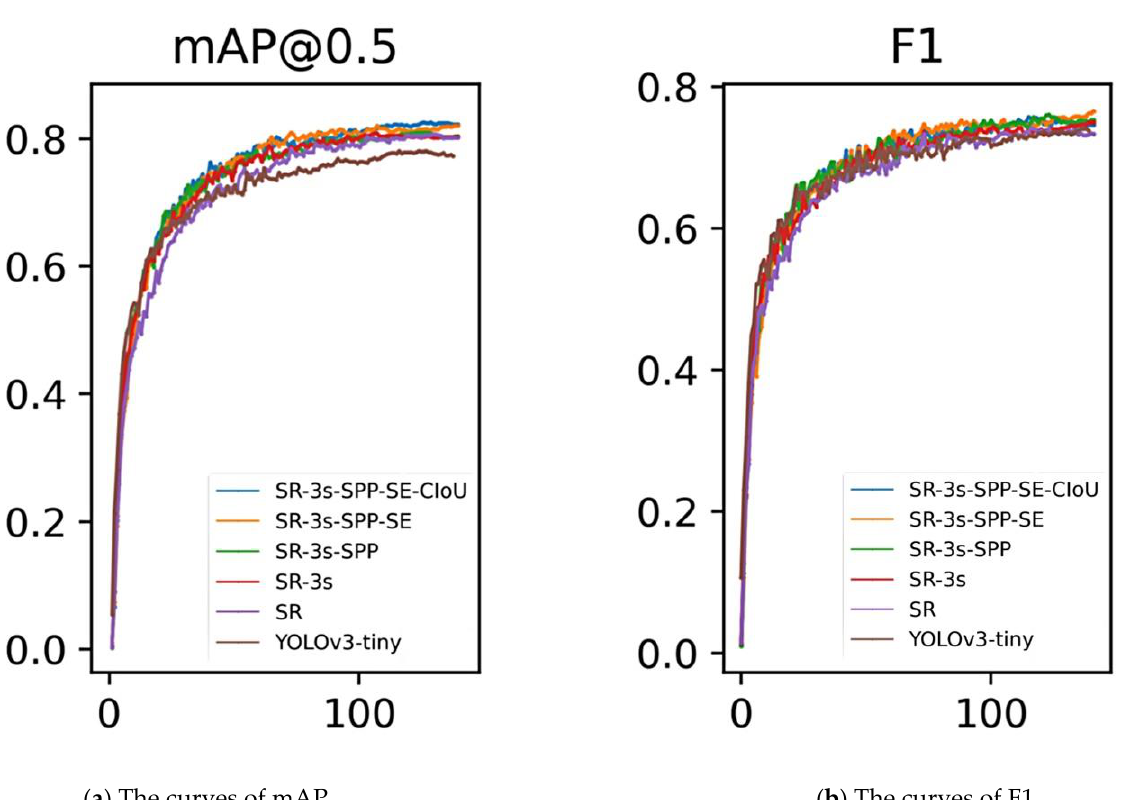
Figure 6. The curves of F1 and mAP in the different models.